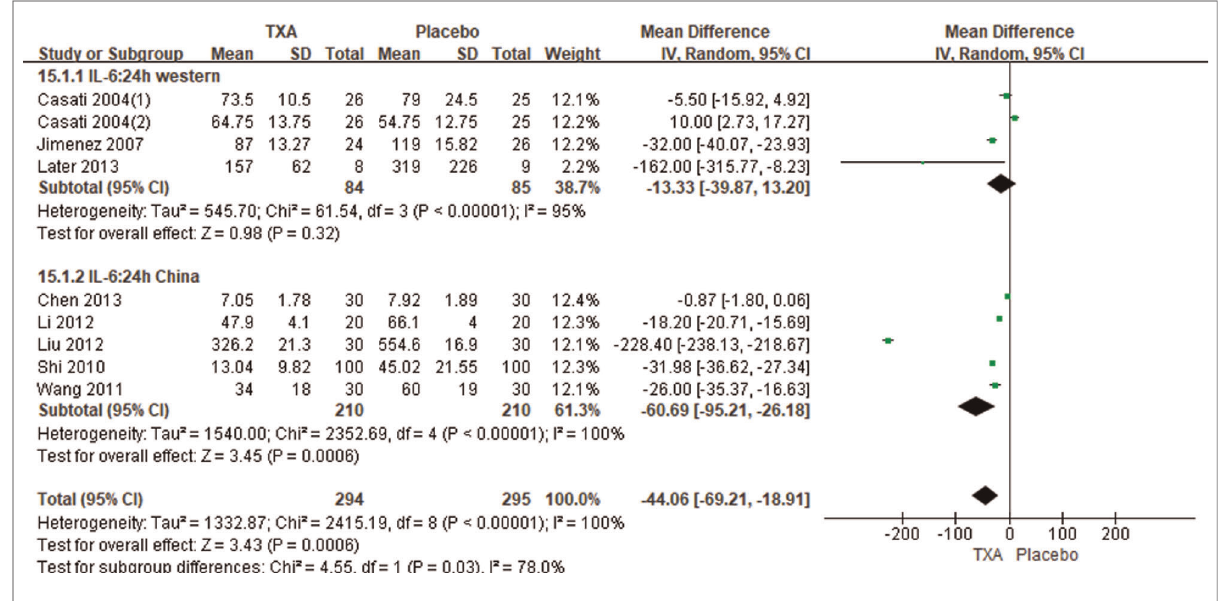
FIGURE 5 Forest plot comparing TXA and placebo for the postaperative 24 h IL-6 level.